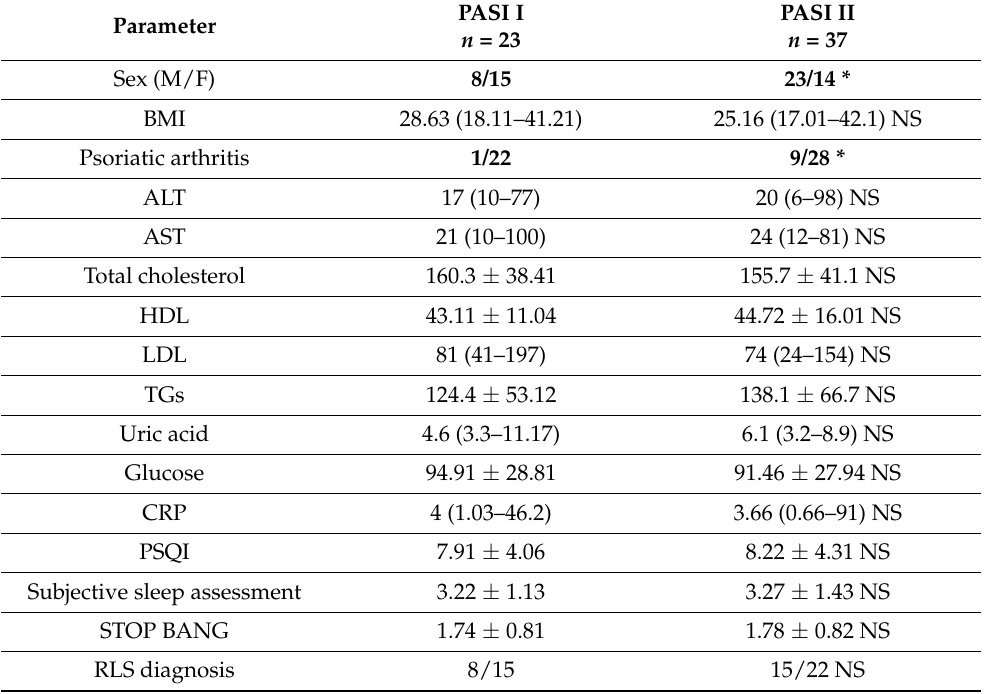
Table 3. Comparison between two subgroups: PASI (Psoriasis Area and Severity Index) I and PASI II in terms of baseline data, standard laboratory parameters, and values of sleep